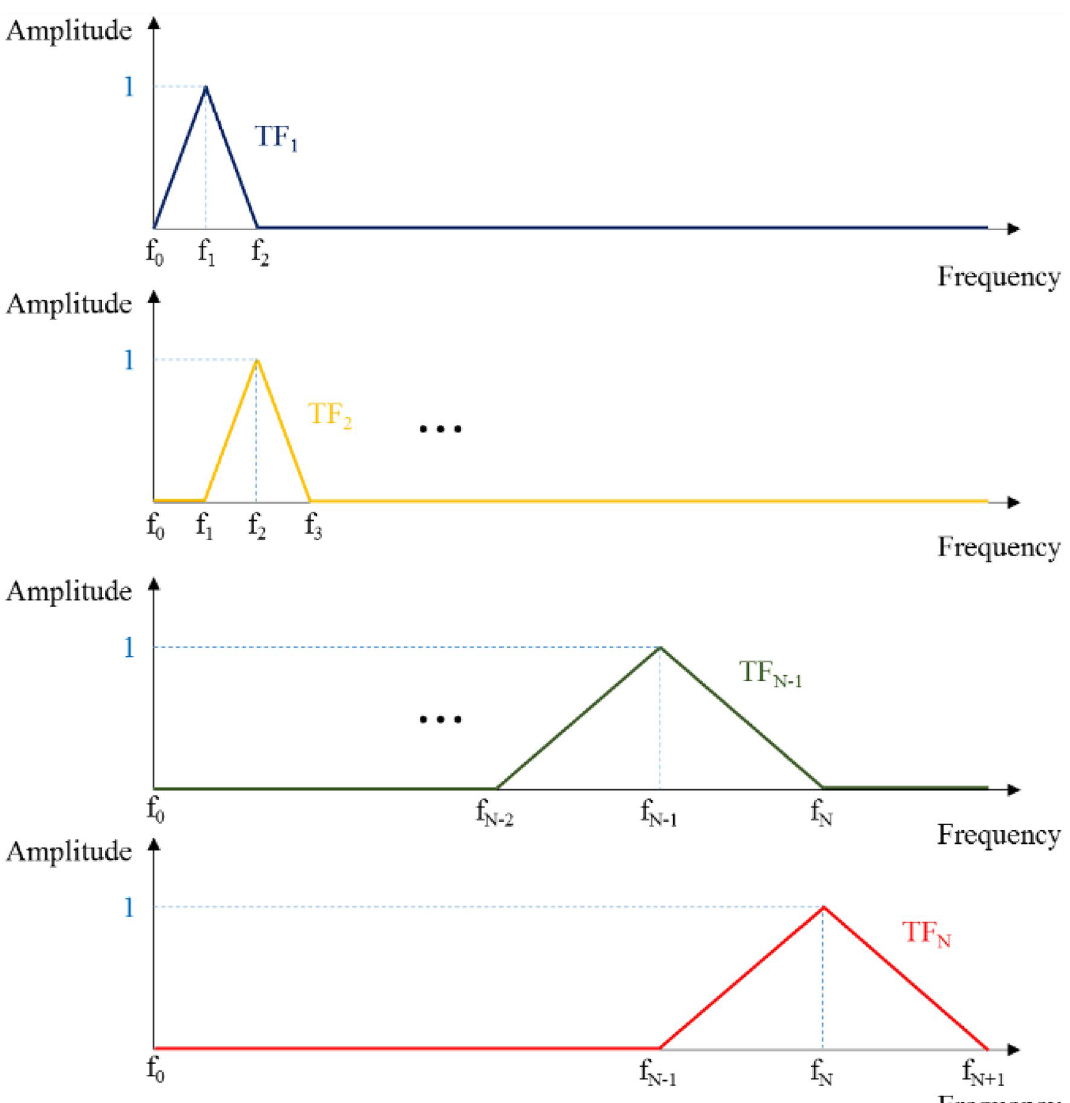
Figure 4. Mechanism of the triangular